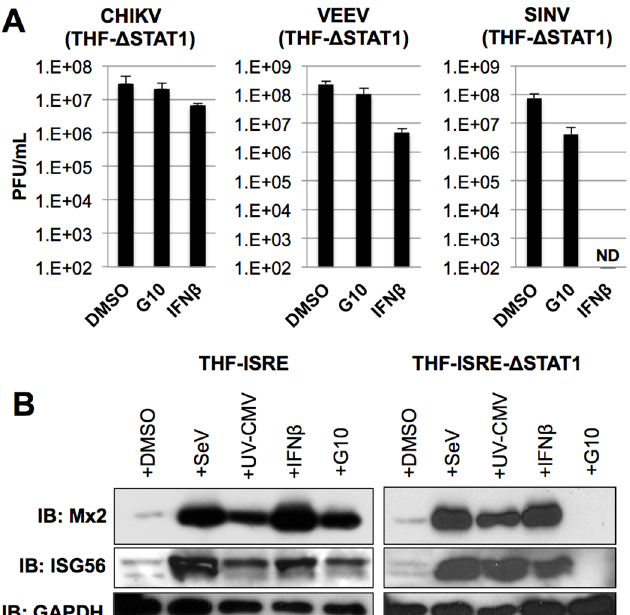
THF-ISRE- Δ STAT1 cells treated with 1% DMSO, 100 μ M G10, or 1000U/mL IFN β as indicated. Infections were performed in triplicate. (B) Synthesis of Mx2 and ISG56 proteins in THF-ISRE and THF-ISRE- Δ STAT1 following 24h exposure to SeV, UV-CMV, 1000U/mL IFN β or 100 μ M G10 as